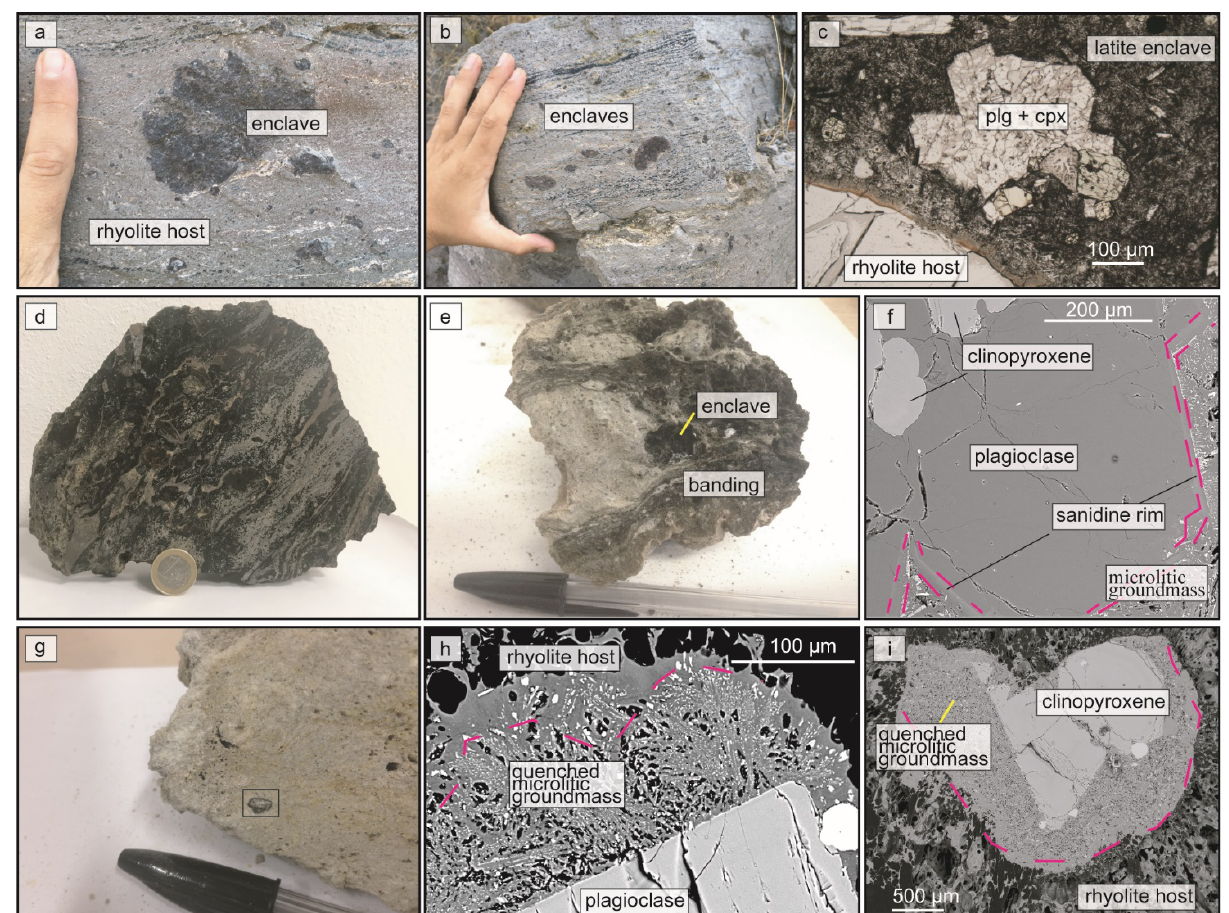
Figure 4. ( a , b ), magmatic enclaves in the rhyolitic Pietre Cotte lava flow (GCEC); ( c ), microphotograph of a crystal-rich latitic enclave and the contact with the rhyolite host of Pietre Cotte lava (GCEC); ( d ), banding in the Commenda rhyolitic lava (PEU); ( e ), banding and magmatic enclave in the trachy-rhyolitic Upper Pietre Cotte pumice (GCEC); ( f ), BSE (backscattered electron) image showing a sanidine rim overgrowth in a plagioclase (magmatic enclave in Upper Pietre Cotte rhyolitic pumice of GCEC); ( g – i ), Pal B (PEU) rhyolitic pumice with a plagioclase and a clinopyroxene crystals wrapped in a quenched microlitic groundmass, the purple dashed line highlights the contact with the host rhyolitic vesiculated glassy groundmass.